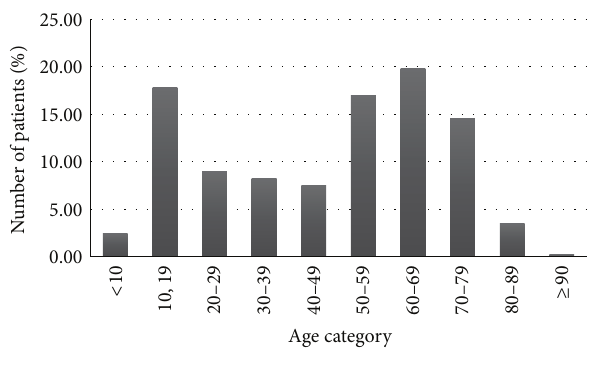
Figure 1: Age distribution of patients.